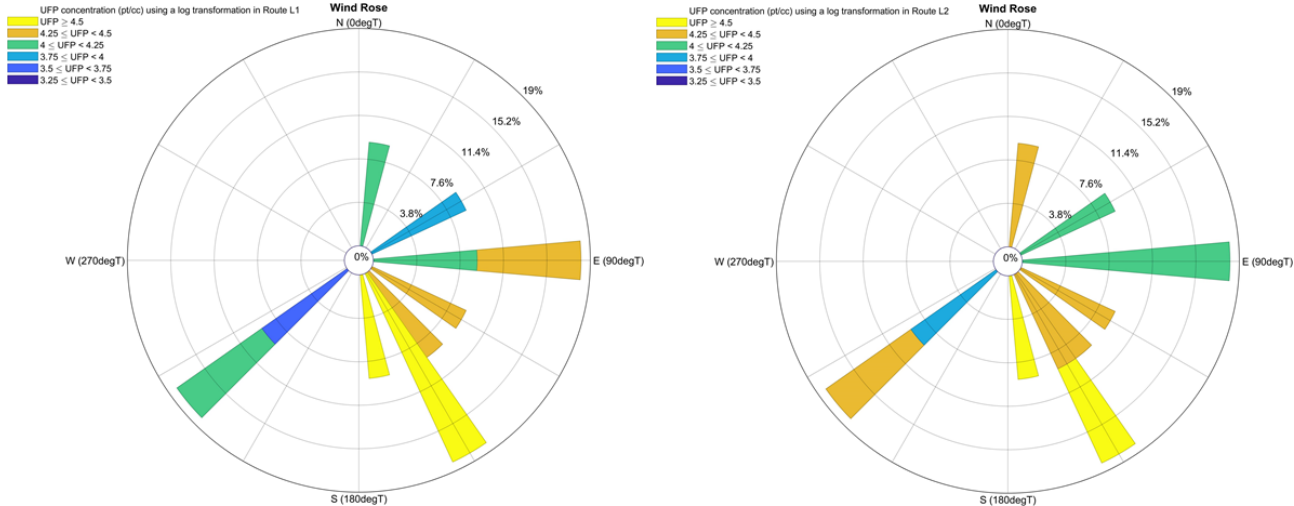
Figure 5. Pollution rose for routes L1 and L2 (a log transformation was used for the UFP concentration). A bar plot of the mean of daily average of each route can be seen in Figure 6. The highest mean of all daily measurements was observed on Route L1 (25,500 ± 21,400 pt/cc),